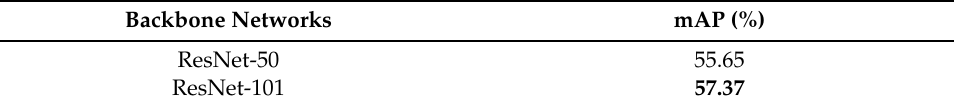
Table 4. The impact of different backbone networks on detection performance. The best result is indicated by